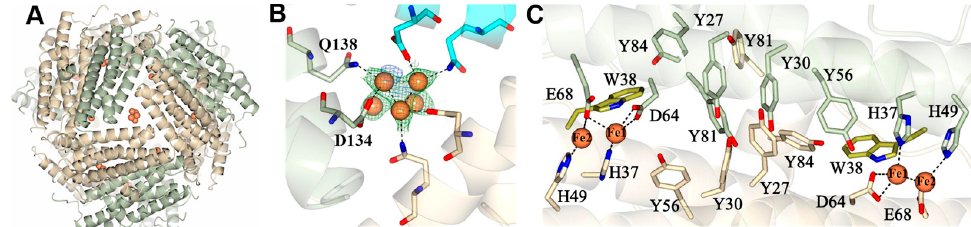
Figure 4. ( A ) View of a cluster of iron ions in a B-type 3-fold pore. ( B ) The side chains of D134 and Q138 in each subunit interact with the iron ions. The phased anomalous difference map (blue mesh) is contoured at 3 σ , and 2Fo-Fc map (green mesh) is contoured at 1 σ . ( C ) View of a C2 symmetry-related dimeric interface in Pa Dps illustrating the two ferroxidase centers and the network of Tyr residues. The two subunits and associated Tyr residues are rendered in green and wheat, and the conserved Trp in both subunits is rendered in yellow. The dotted lines highlight coordination of iron by ferroxidase center ligands.